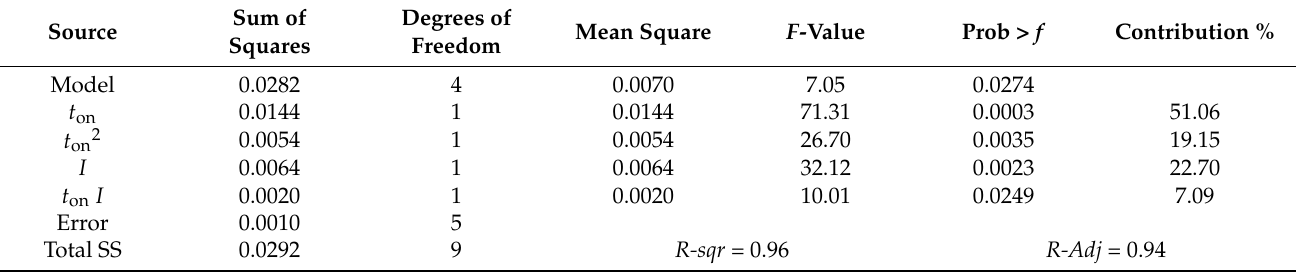
Table 7. ANOVA table for slot width S (after elimination).